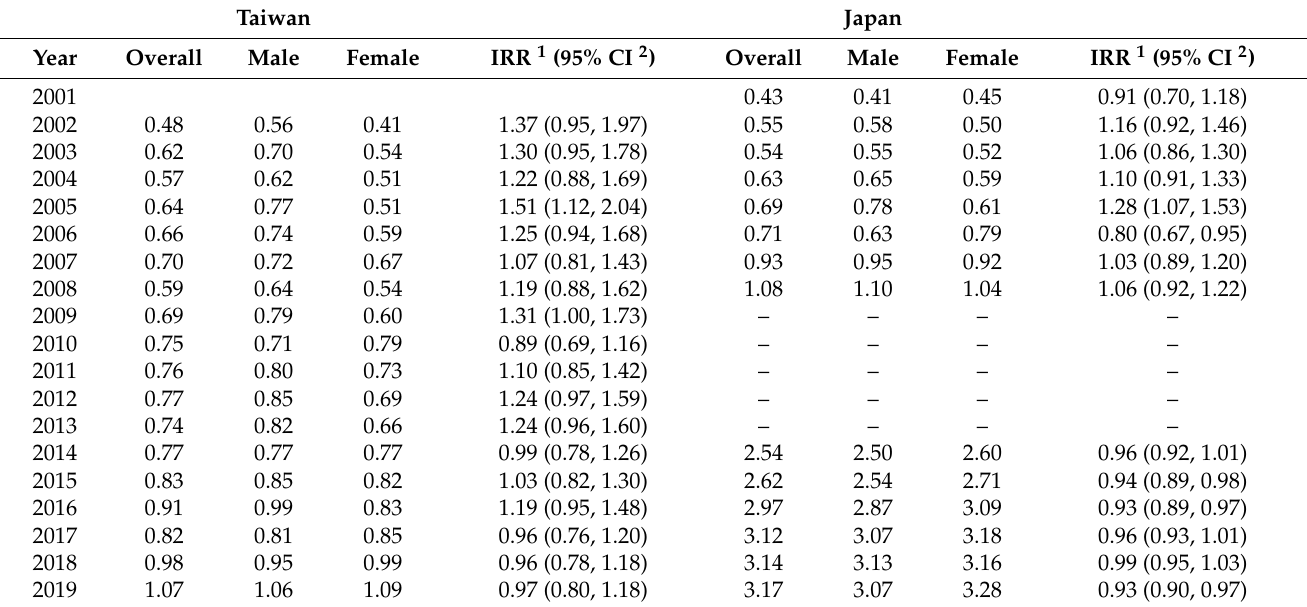
Table 1. Age-adjusted rates per 100,000 and male-to-female IRR in Taiwan and Japan. Taiwan